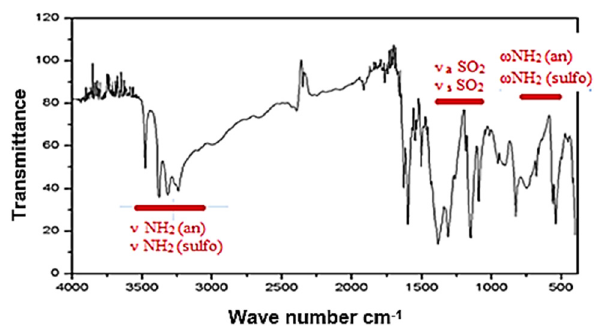
Figure 5: IR spectrum of the complex ( 1 ) in the range of 4,000 – 400 cm − 1 .